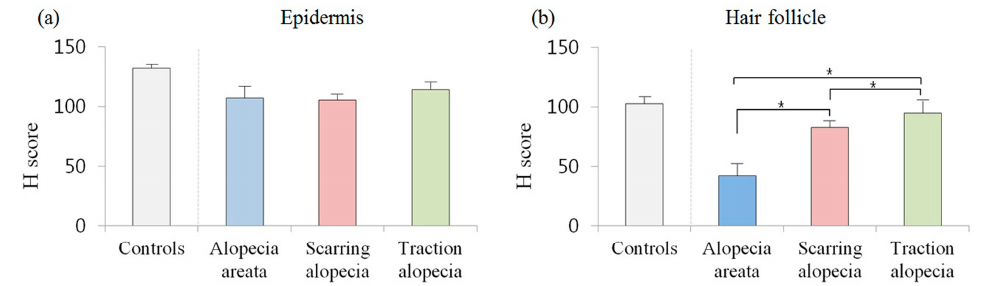
Figure 7. Comparison of Erdr1 expression in alopecia subgroups; The intensities of Erdr1 expression levels in alopecia areata, scarring alopecia, and traction alopecia were quantitatively evaluated using the HistoQuant™ H score; ( a ) The mean H score for Erdr1 expression in the epidermis of various hair loss disorders; ( b ) Erdr1 expression in the hair follicles of various hair loss disorders. * indicates a p -value less than 0.05.